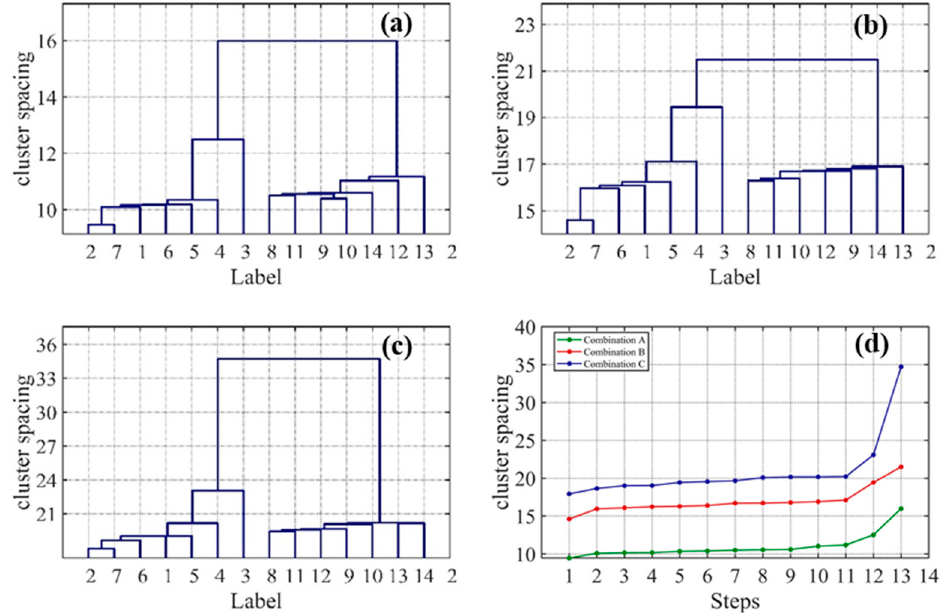
Figure 3. Data training set hierarchical cluster tree and cluster distance folding line change diagram. ( a ) Combination A Stokes dataset ( b ) Combination B Stokes and DOLP dataset ( c ) Combination C Stokes, DOLP, and pBRDF matrix element dataset ( d ) Combining hierarchical cluster distance folding line change diagram with data.